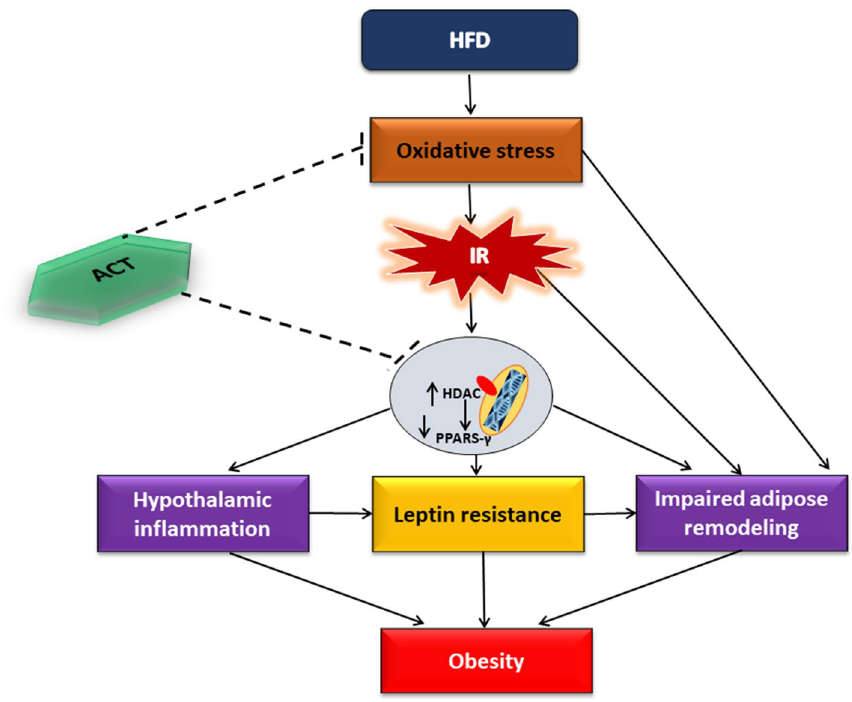
Figure 12. Schematic diagram showing the possible effects of acetate and the involvement of PPAR-γ in brain-adipose network in the development of obesity. HFD High fat diet, ACT Acetate, PPAR-γ Peroxisome proliferator-activated receptor-γ, HDAC Histone